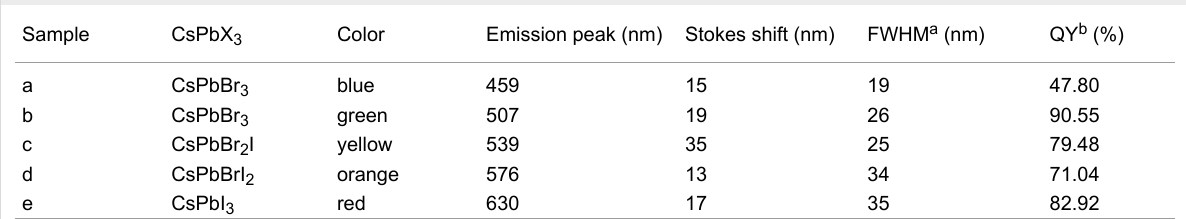
Table 1: Characteristics of the CsPbX 3 quantum dots.